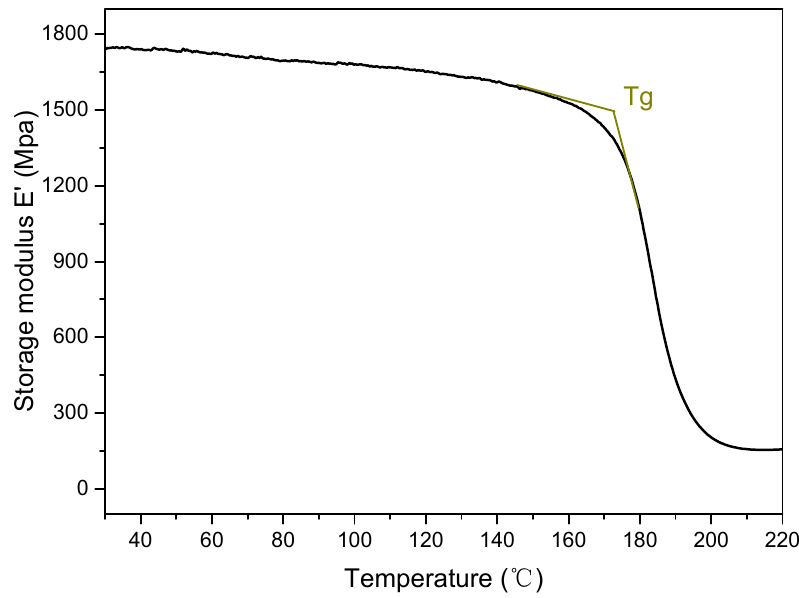
Figure 4. Dynamic mechanical analysis ( DMA) temperature sweep results of epoxy resin.